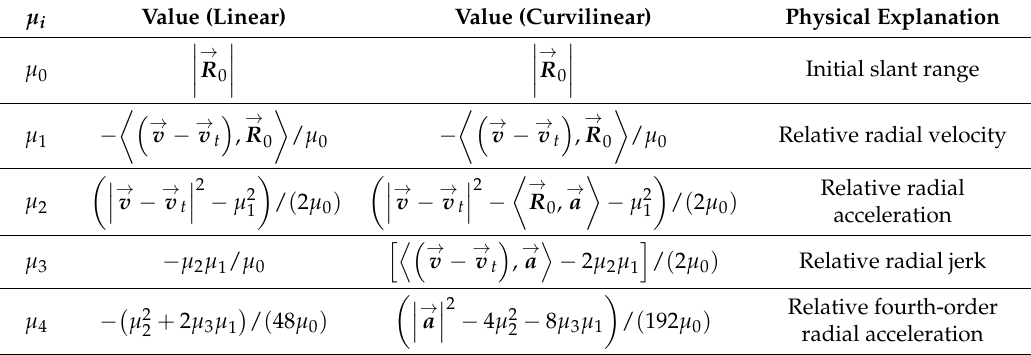
Table A1. Values and physical explanation for the i th order coefficient with different